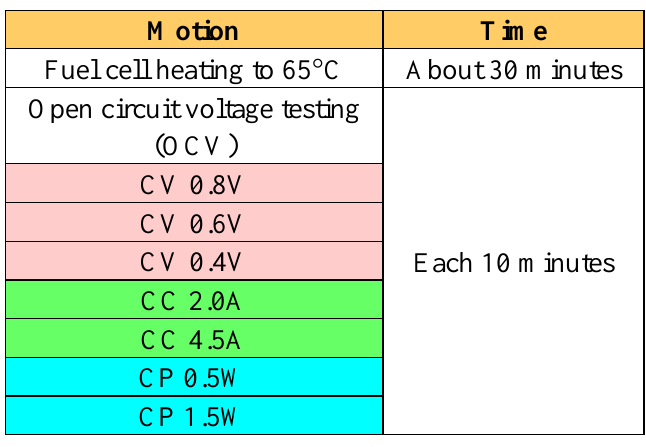
Table 2. Fuel cell testing